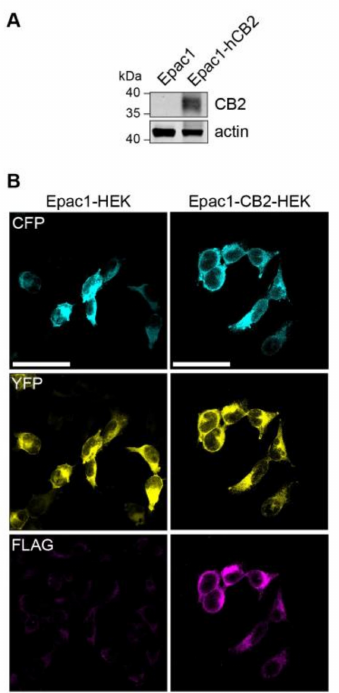
Figure 1. Expression of FLAG-CB2 and Epac1-camps in Epac1 and Epac1-CB2-HEK cells. ( A ) Western Blot of FLAG-CB2 and mock-transfected Epac1-HEK cells after selection process used in all further experiments with detection for CB2 receptor and actin as loading control. ( B ) Representative confocal microscopy images of immunofluorescent detection of Epac1-camps and FLAG-CB2. First column of images shows Epac1-HEK and the second column shows Epac1-CB2-HEK cells. Cyan fluorescent protein (CFP) (cyan) and yellow fluorescent protein (YFP) (yellow) fluorescent signals are seen in the first two rows respectively. FLAG-staining for FLAG-CB2 is seen in the third row of images (magenta). Scale bar = 50 µ